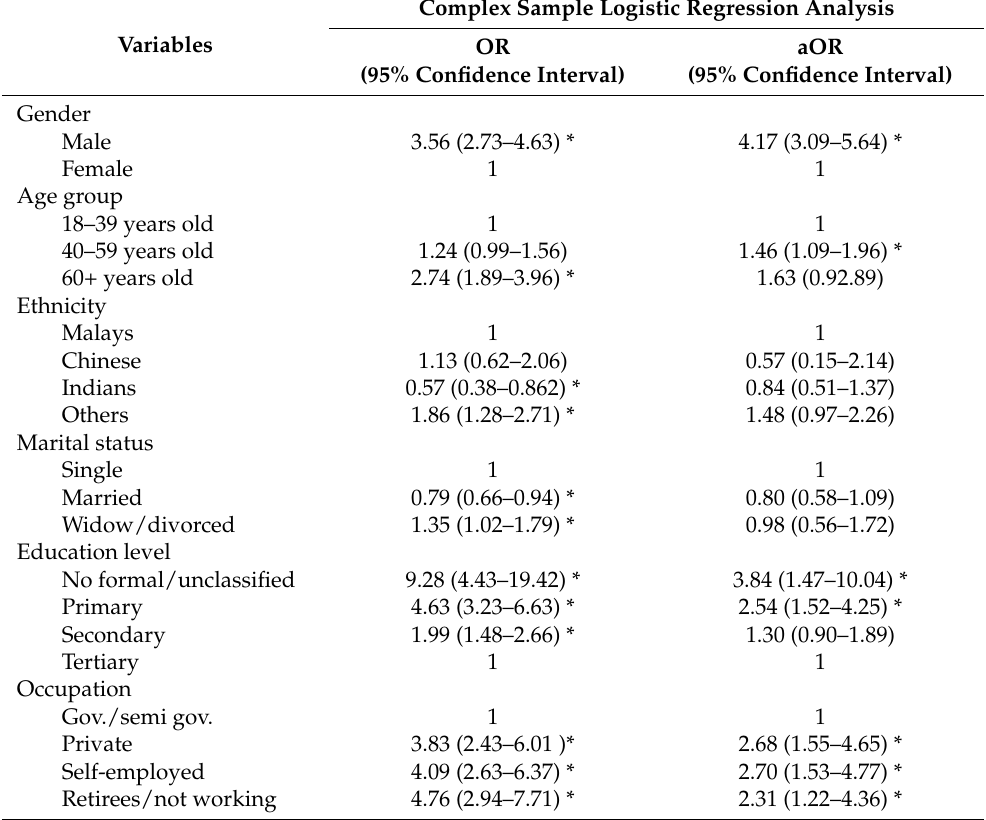
Table 2. Factors associated with unawareness of “Malaysian Healthy Plate” in rural